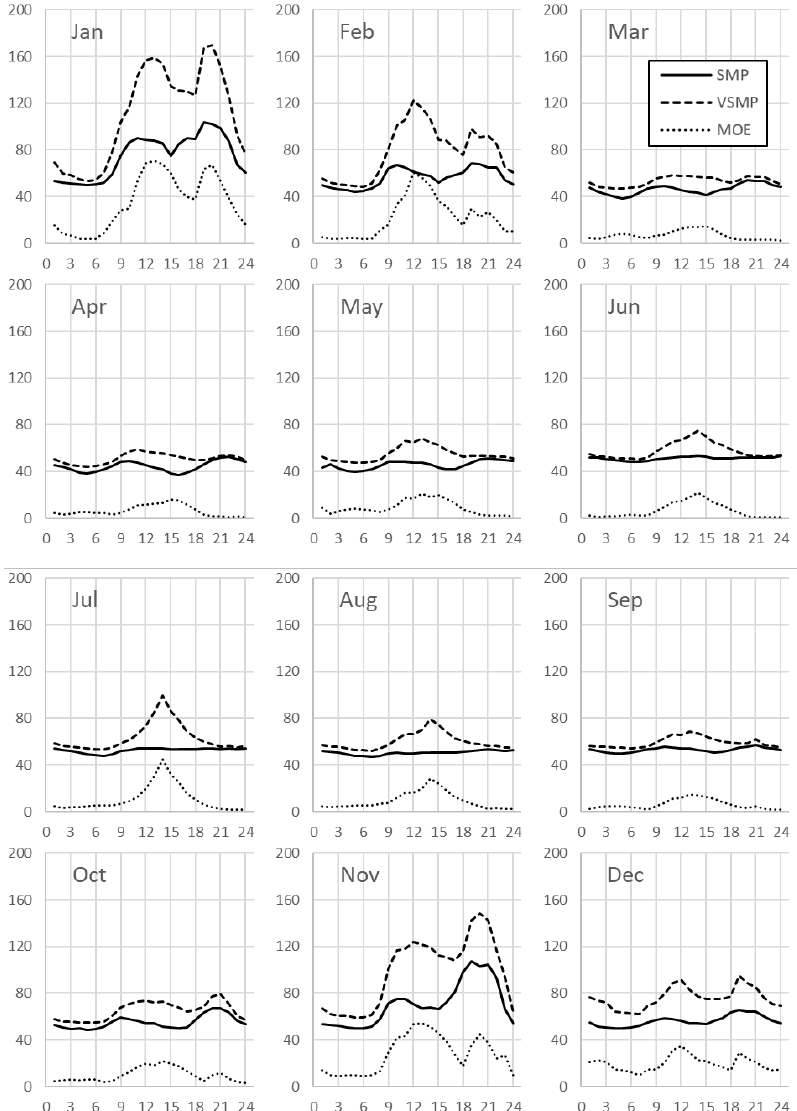
Figure 7. Daily variation using monthly-averaged hourly data: VSMP = virtual system marginal price, SMP = system marginal price, MOE = merit order effect. Horizontal axis = hour of the day, vertical axis = price in €/MWh .